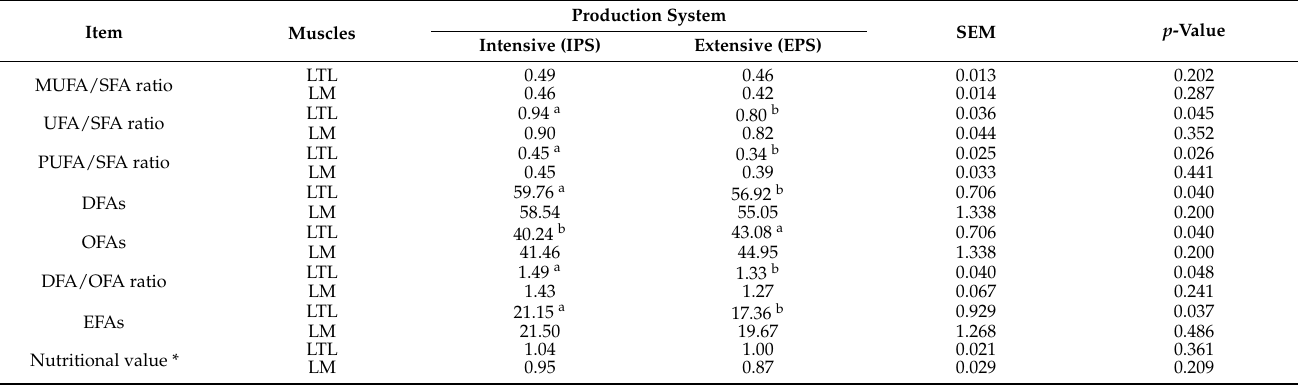
Table 4. Indicators of the nutritional value of intramuscular fat in the Longissimus thoracis et lumborum (LTL) muscle and leg muscles (LM) of New Zealand White